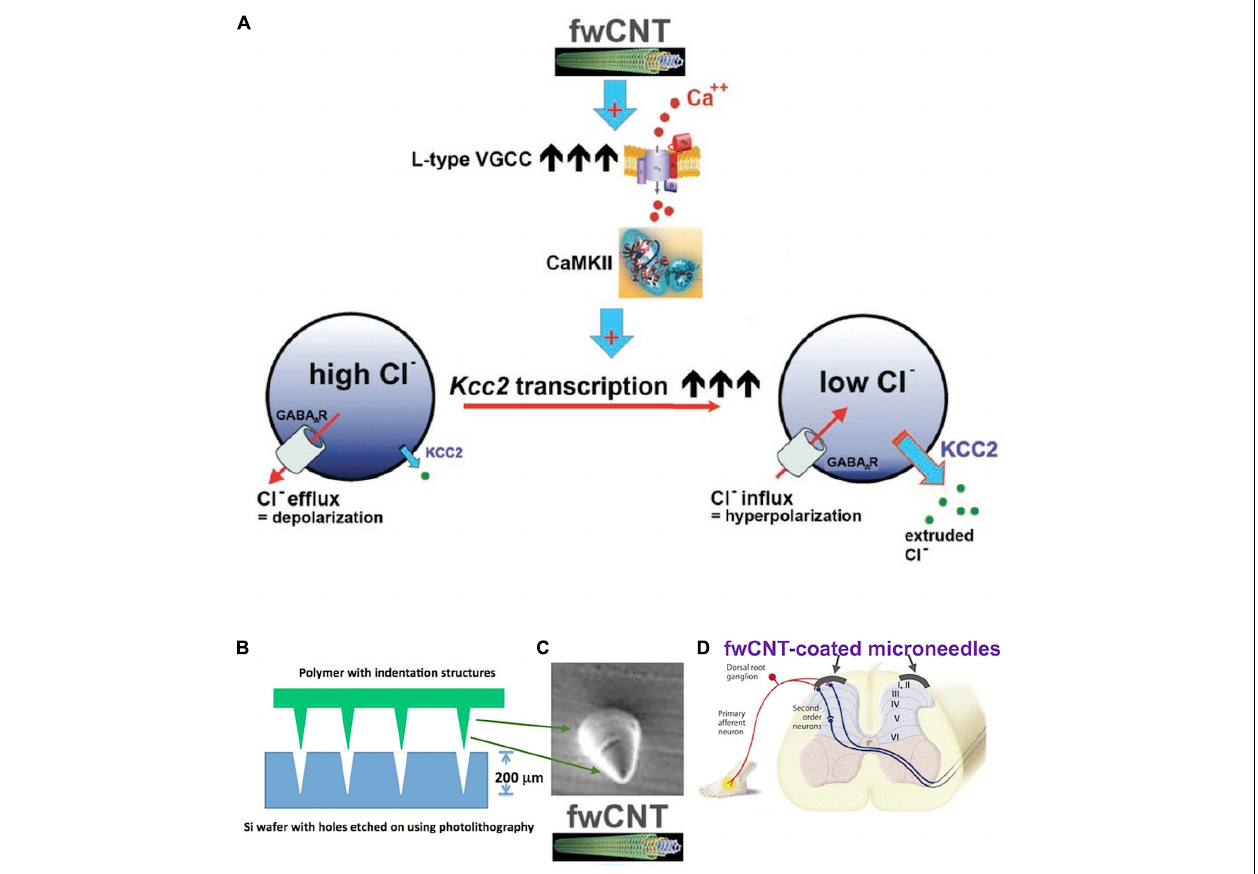
FIGURE 6 | Kcc2 gene expression-enhancement based on few-walled carbon nanotubes for coating of microneedle-related insertional devices, for insertion into the spinal cord dorsal horn. (A) Summary figure of a previous study by Liedtke et al. (2013) that drives home the point of electrically conductive few-walled carbon nanotubes (fwCNT) robustly enhancing Kcc2 gene expression, via a mechanism of calcium-influx mediated activation of CaMKII. (B) A future neuroprosthetic device for enhancement of Kcc2 gene expression can be fabricated with approximate insertion depth of 200 µ m, using biodegradable (or non-degradable, yet biocompatible) polymers and microtechnology fabrication methods. (C) Cone-shaped single needle at 200 µ m height, intended for microneedle format (array density at 50–100/cm), for subsequent coating with fwCNT. (D) Suggested insertion of the fwCNT-coated microneedle device into the spinal cord dorsal